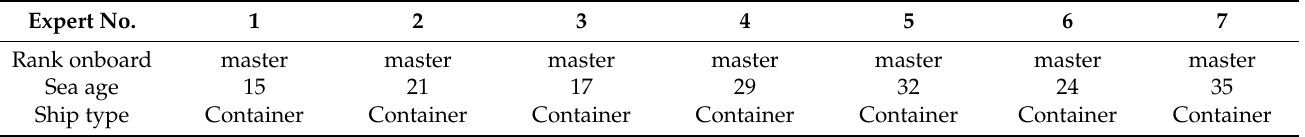
Table 3. Experts’ profiles.